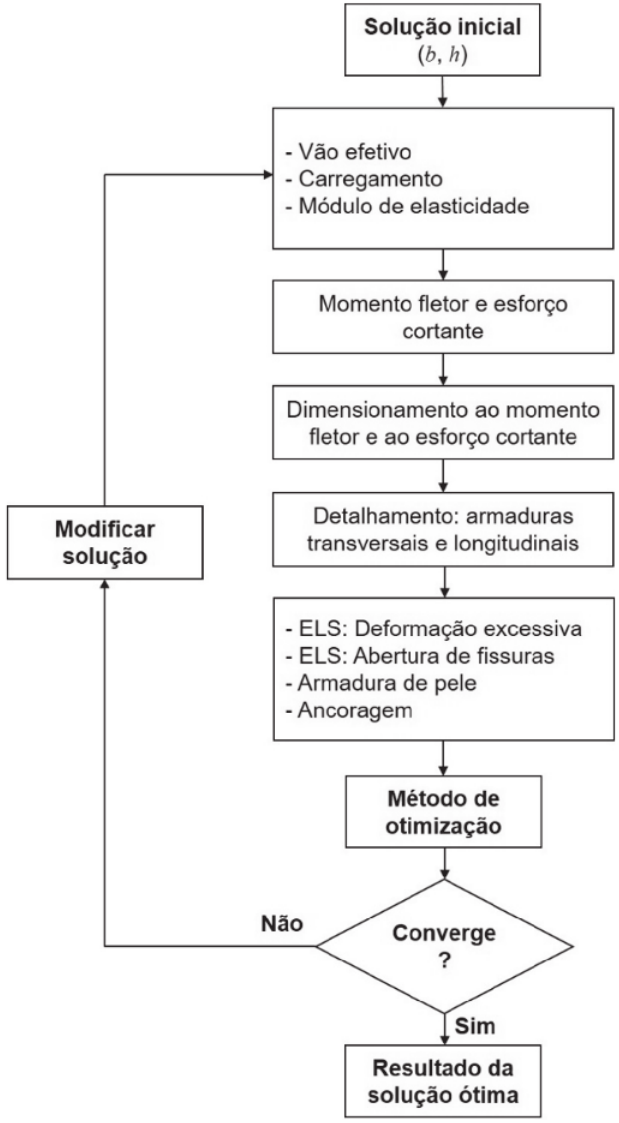
Fluxograma do dimensionamento otimizado da